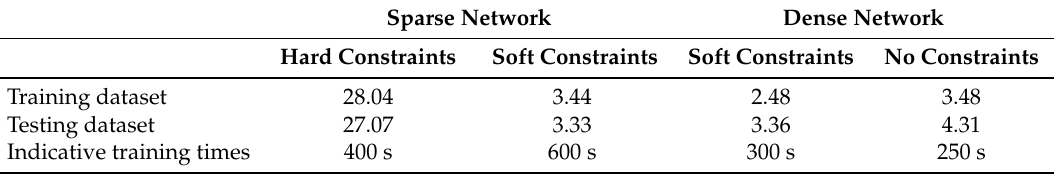
Table 3. Price RMSE (absolute pricing errors) and training times with Dupire penalization.